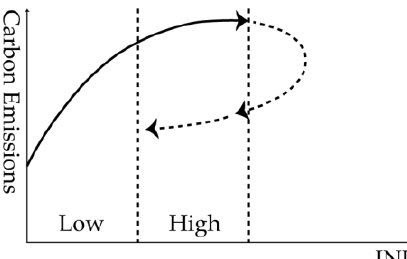
Figure 4. Opening P curve of environmental regulation on carbon emissions.